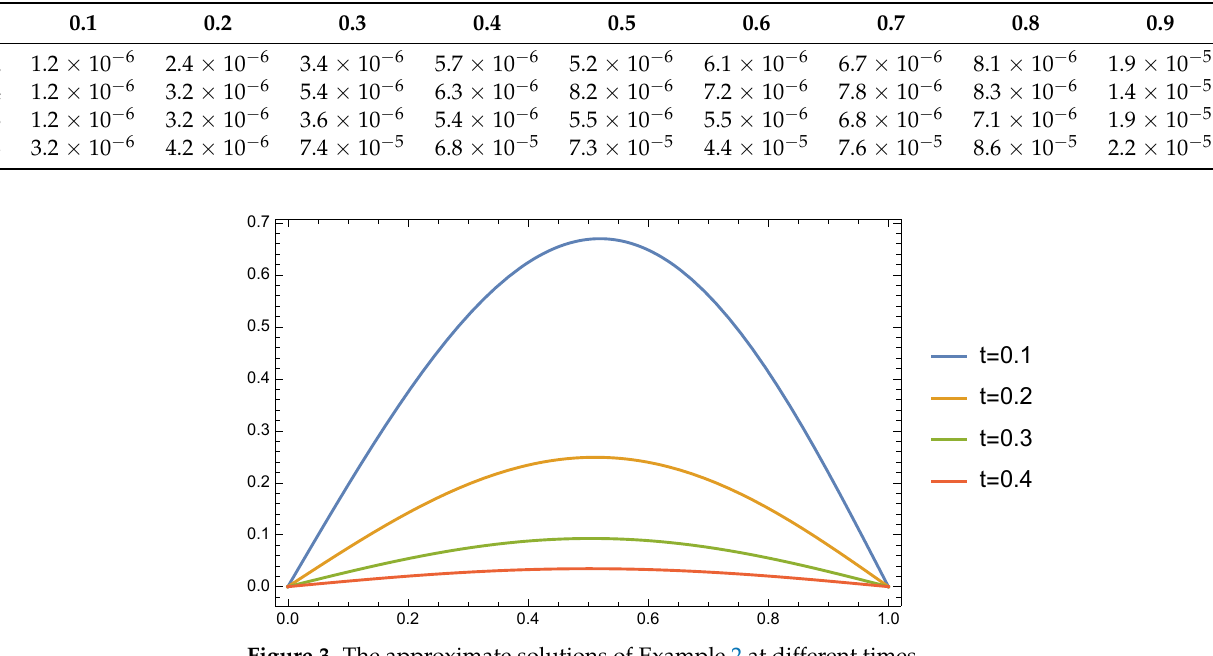
Figure 3. The approximate solutions of Example 2 at different times.